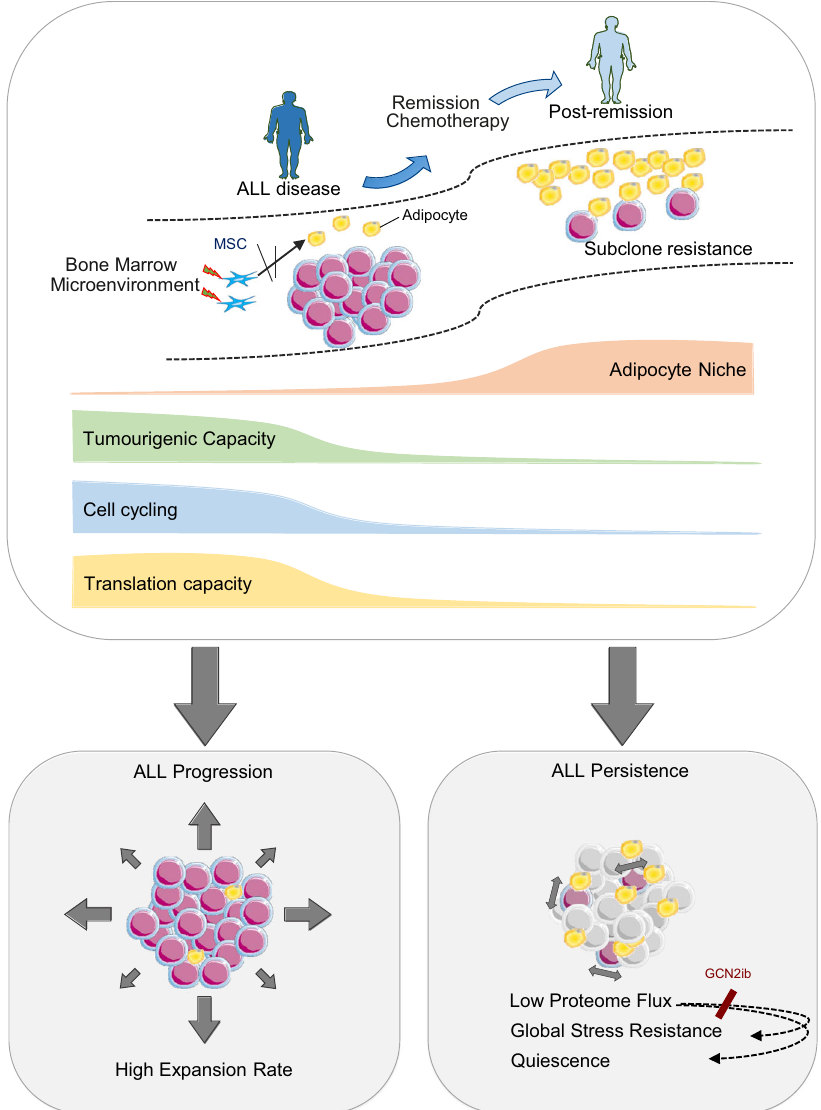
Fig. 6 a Adipocyte niche function in ALL disease. Graphical abstract showing the temporal course of adipocyte niches across the ALL disease-remission transition and its pathophysiological relevance based on the demonstration of adipocyte-driven modulations in ALL cell